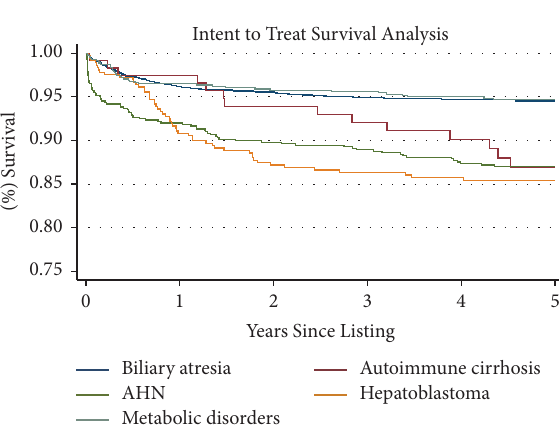
Figure 1: Intent-to-treat survival analysis. Kaplan–Meier survival function over 5 years for patient survival in pediatric patients listed for liver transplant from listing until death, regardless of transplantation status, by